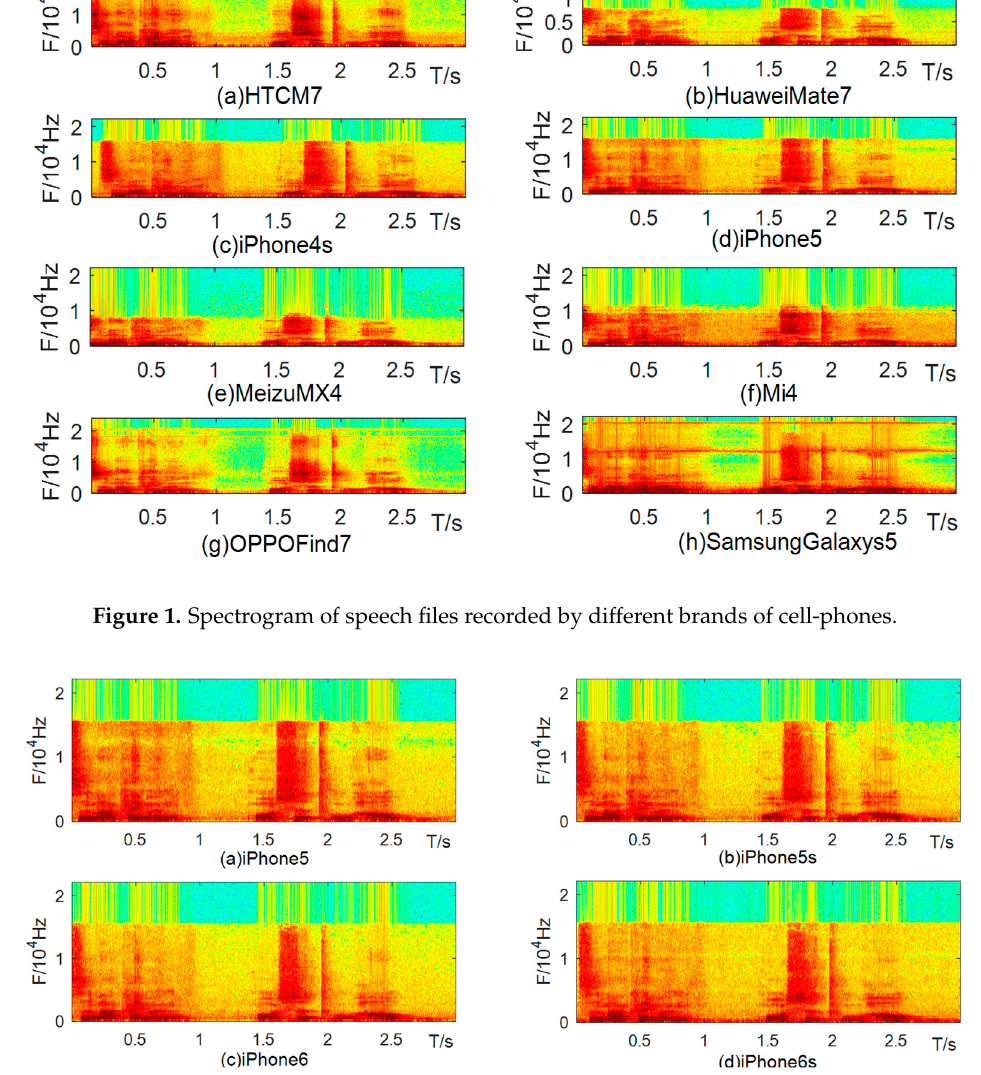
Figure 2. Spectrograms of speech files recorded by different models of Apple cell-phones.